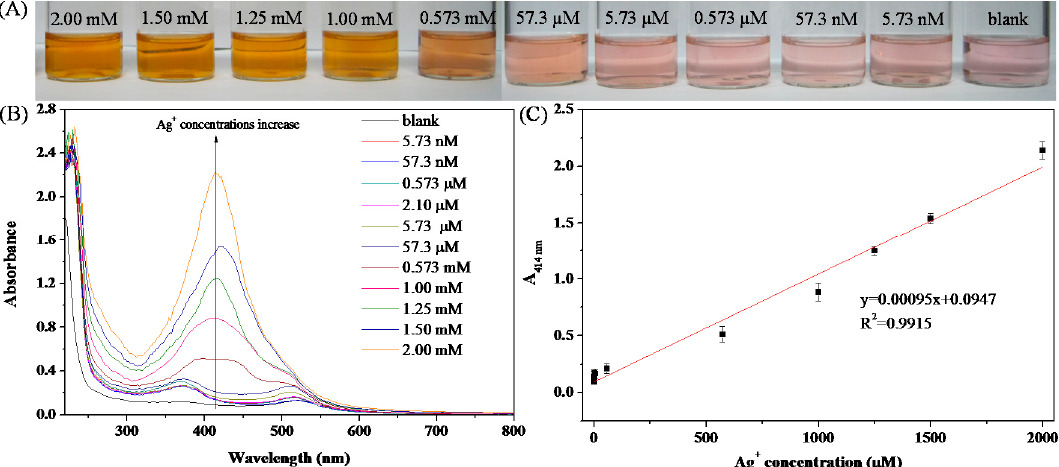
Figure 9. ( A ) Photographs and ( B ) UV-vis absorption spectra of 0.49 nM HPEI-IBAm-AuNPs solution in the presence of different Ag + concentration (0–2.0 mM); ( C ) linear response ( A 414 nm value of the